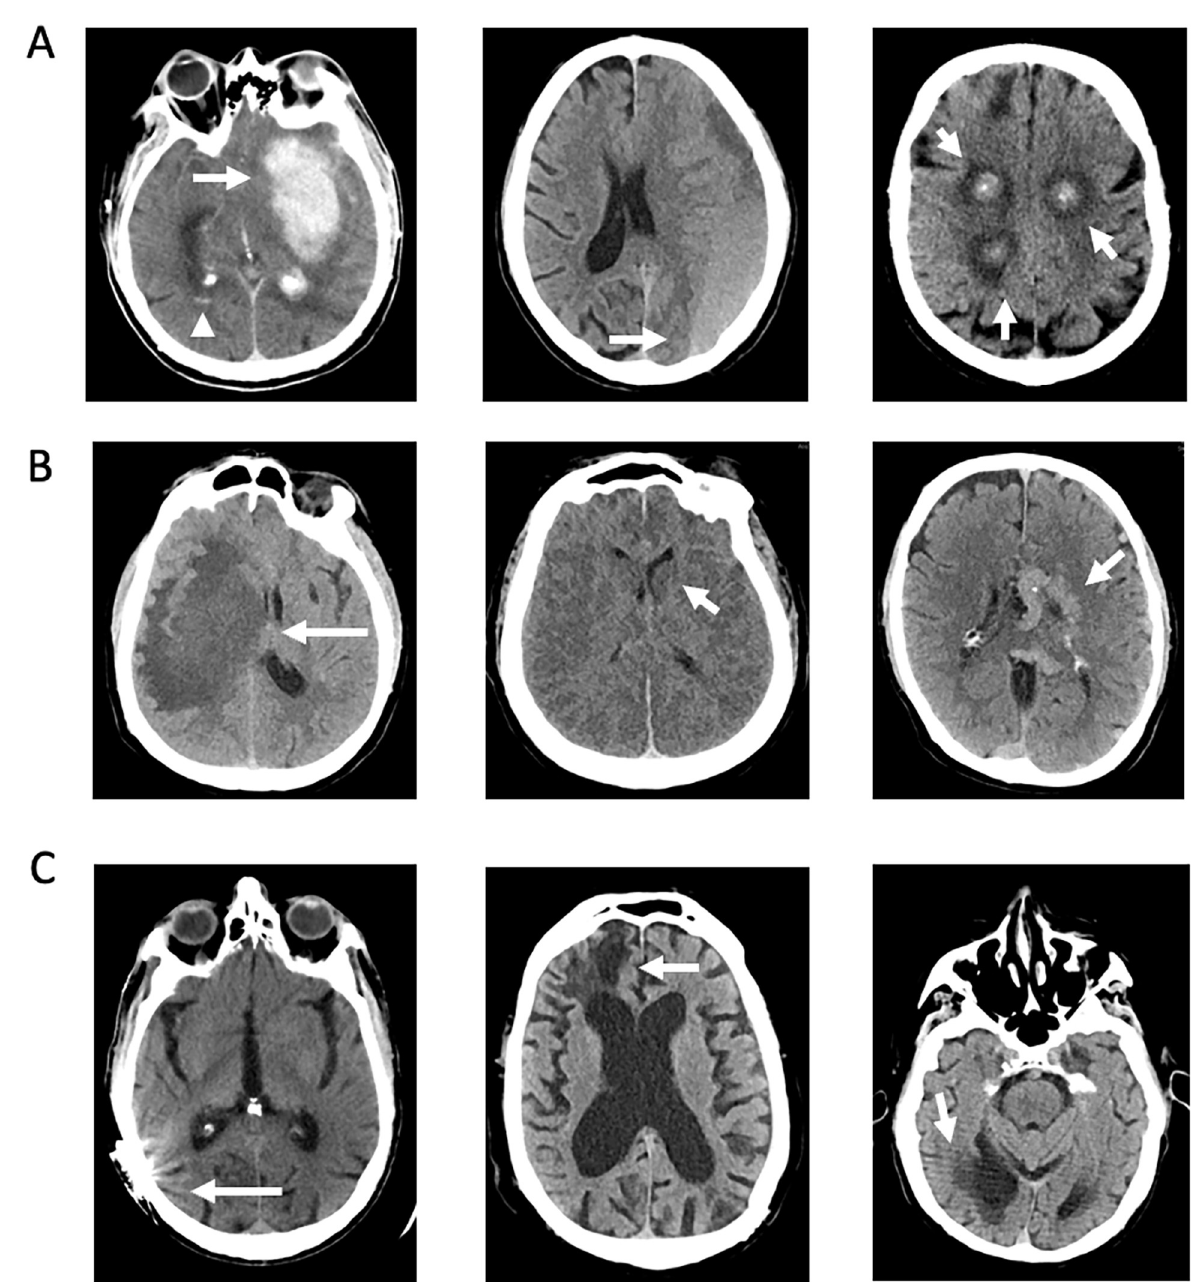
Fig 1. IC+ cases. A: Examples of IC+ cases with acute intracranial hemorrhages. The left panel shows a large intraparenchymal hematoma centered in the left basal ganglia (arrow) as well as intraventricular hemorrhages within the bilateral occipital horns (arrowhead). The middle panel shows a large left holohemispheric subdural hematoma with rightward subfalcine herniation. The right panel shows multifocal, hemorrhagic lung cancer metastases. B: Examples of nonhemorrhagic IC+ cases. The left panel shows a large area of confluent hypoattenuation involving the right hemisphere, which was subsequently found to be toxoplasmosis in a patient with human immunodeficiency virus (HIV) and acquired immunodeficiency syndrome (AIDS). The middle panel shows diffuse reversal of gray-white differentiation as well as partial effacement of the ventricles, most consistent with diffuse cerebral edema from a severe hypoxic-ischemic injury. For instance, the left caudate head has an abnormally hypodense appearance compared to the adjacent internal capsule. The right panel shows a large, left hemispheric, Spetzler Martin grade 5 arteriovenous malformation. C: Examples of false positive IC+ cases. The left panel shows streak artifact from metallic hardware. The middle panel shows encephalomalacia of the right frontal lobe. The right panel shows an old right posterior cerebral artery territory infarction.